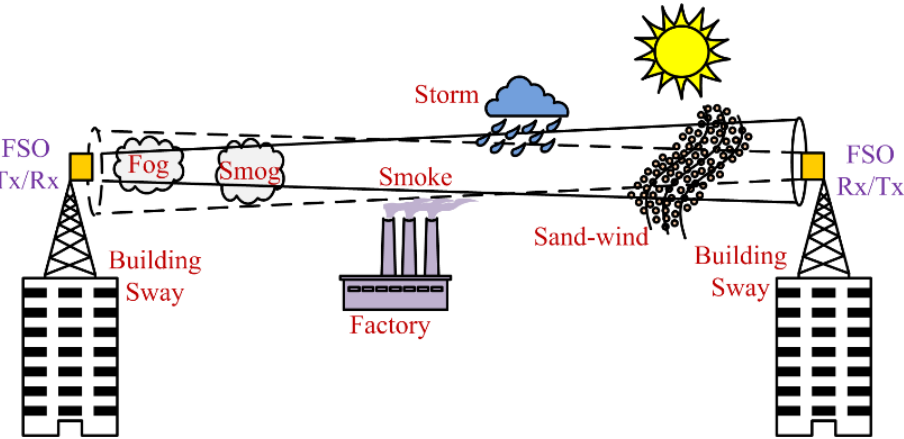
Figure 4. FSO communication channel factors.